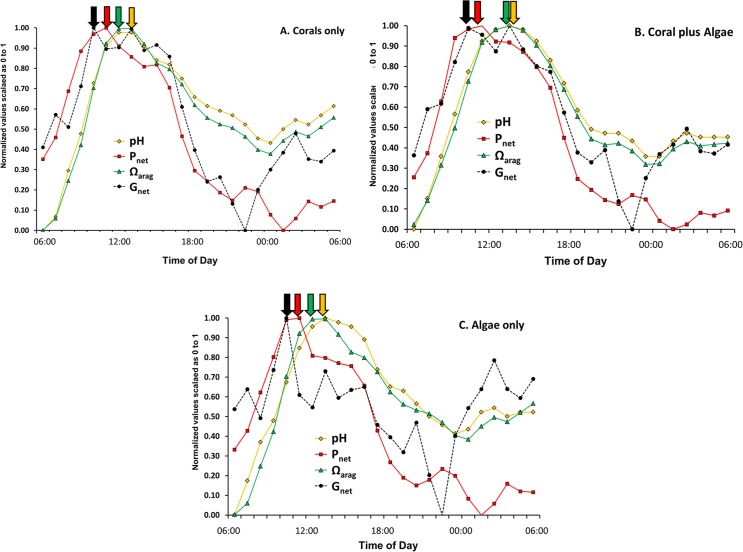
Normalized pH, Ωarag, Pnet and Gnet values for the three mesocosms versus time of day using data from Table 2 and Eq. (9).Arrows point to relative maxima for each parameter.